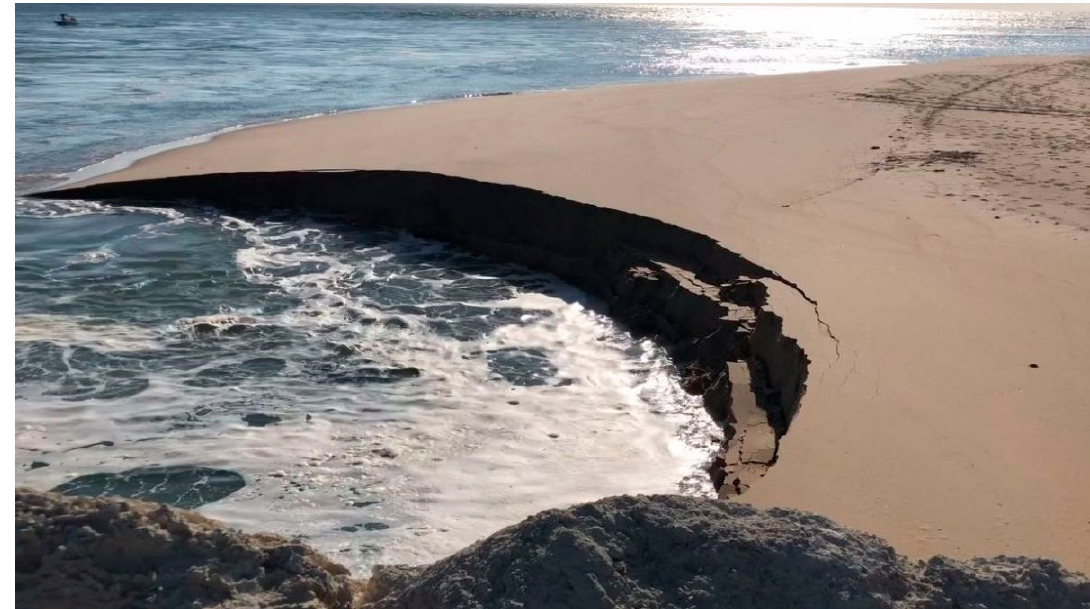
Figure 12. Active flow slide or RBF event at Cap Ferret, 8 February 2018. For safety, the beach was closed for bathers. Photo: Denis Salle, France 3 Nouvelle-Aquitaine.